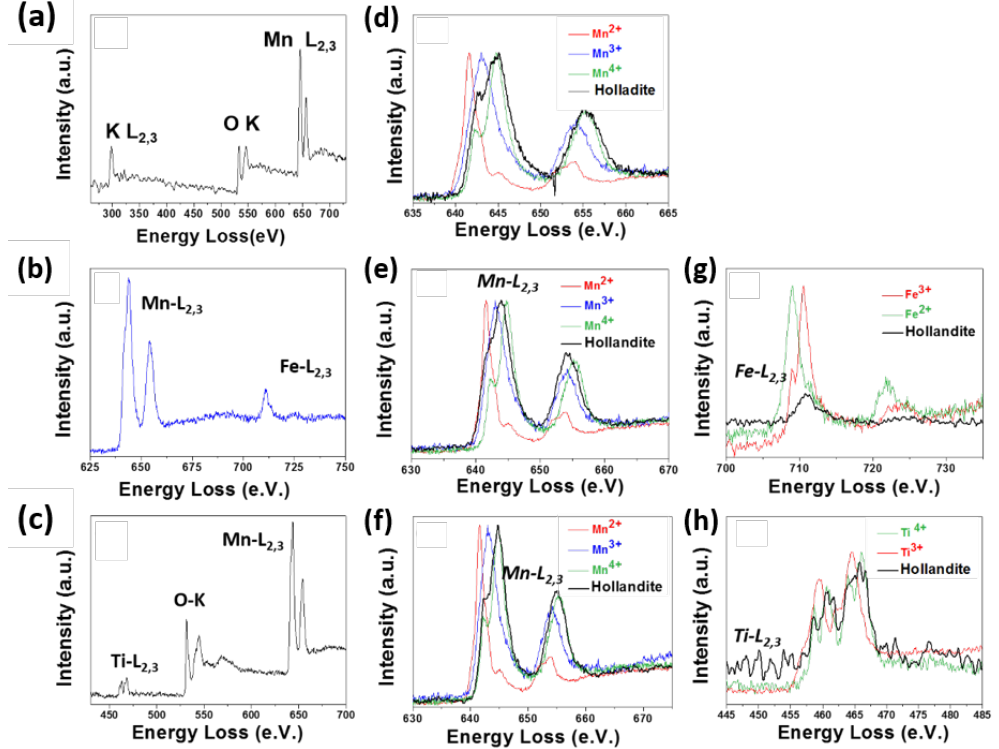
Figure 13. ( a – c ) EELS spectra characteristics of the undoped, and Fe-doped, and Ti-doped hollandites; ( d ) Mn L 2,3 of undoped sample; ( e ) Mn L 2,3 of Fe-doped sample; ( f) Mn L 2,3 of Ti-doped sample; ( g ) FeL 2,3 of Fe-doped hollandite; ( h ) TiL 2,3 of Ti-doped hollandite.